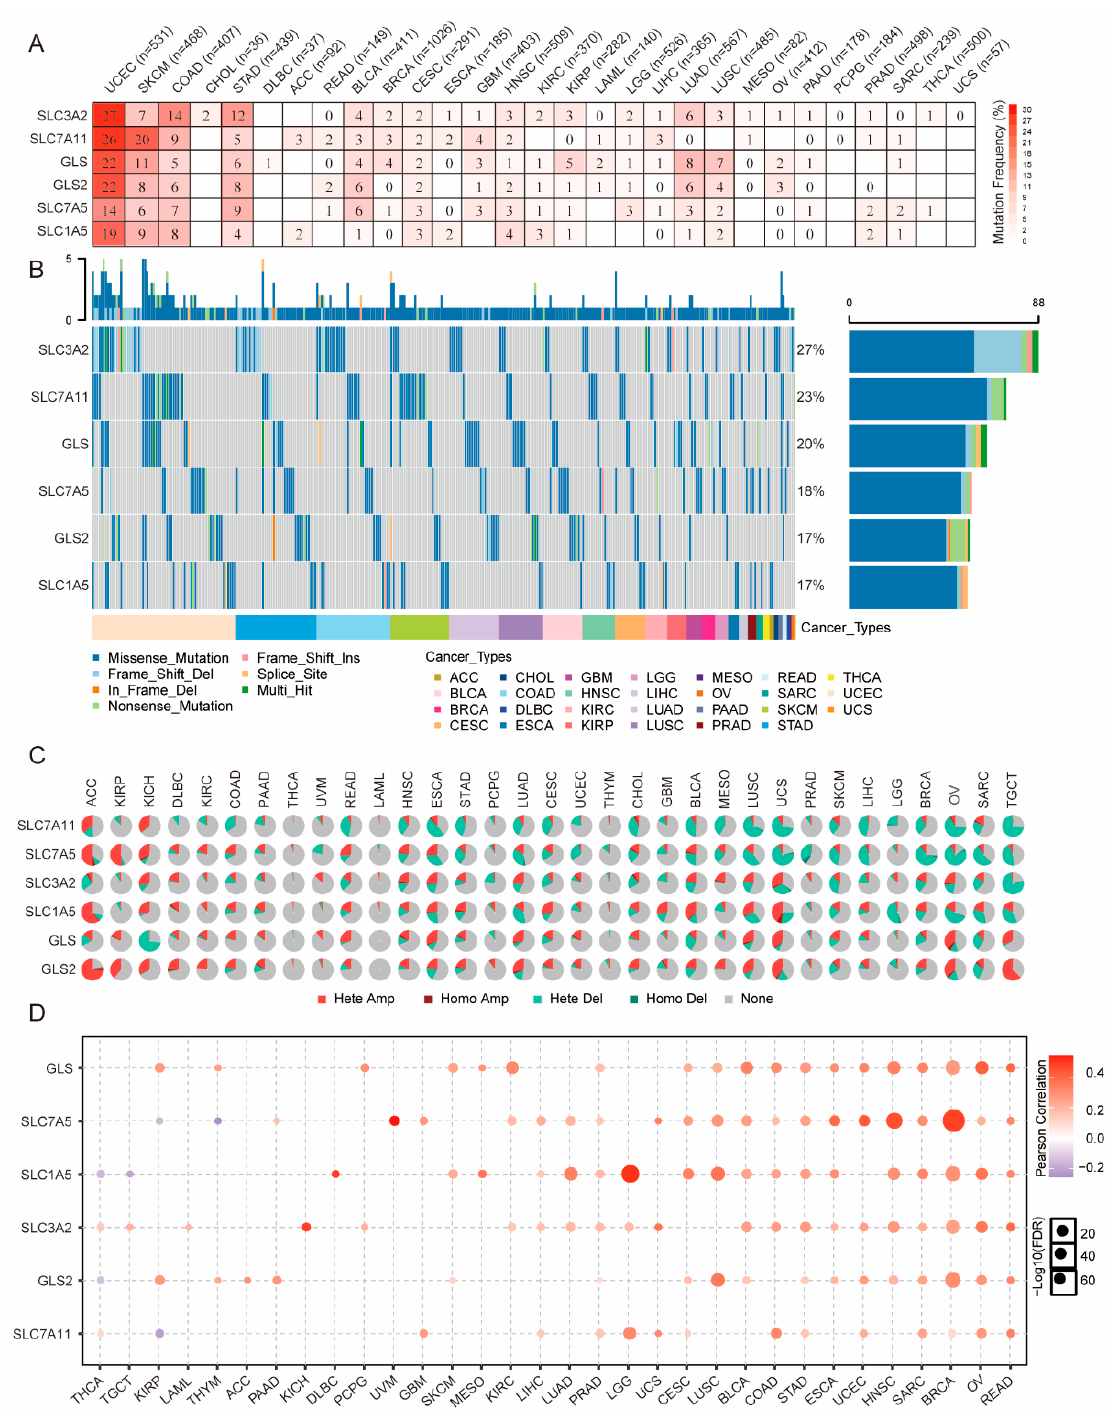
Figure 3. Associations between glutamine metabolism (GLNM) regulators, genomic features, and expression: ( A ) heatmap showing the single-nucleotide variation (SNV) frequencies of six GLNM regulators across different cancer types; ( B ) waterfall plot showing the mutation distribution and classification of SNV types; ( C ) copy number variation (CNV) pie plot showing the proportions of different types of CNVs in each gene across different cancer types; ( D ) correlation between CNV and mRNA expression. Blue dots represent negative correlations and red dots represent positive correlations. The sizes of dots represent significance. Hete Amp: heterozygous amplification; Hete Del: heterozygous deletion; Homo Amp: homozygous amplification; Homo Del: homozygous deletion; None: no CNV.